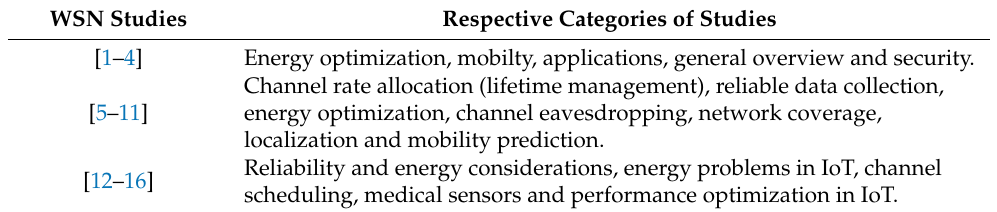
Table 1. WSN studies and categories of